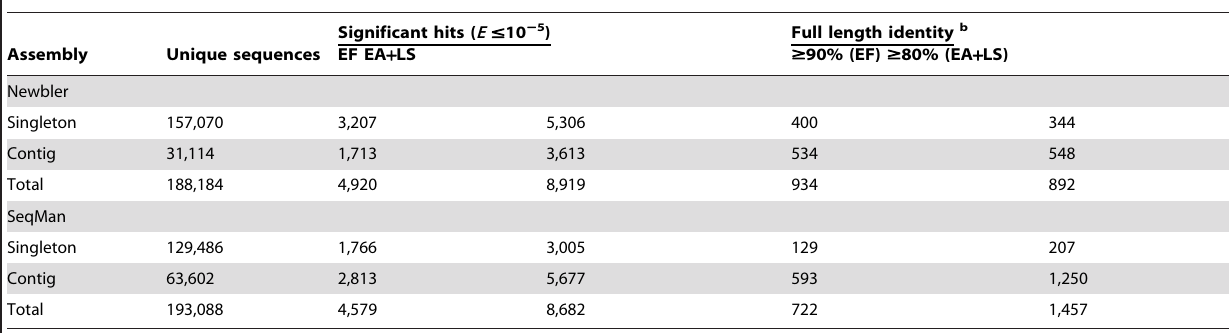
Table 2. Correctness test of two assemblies using BLASTN a .